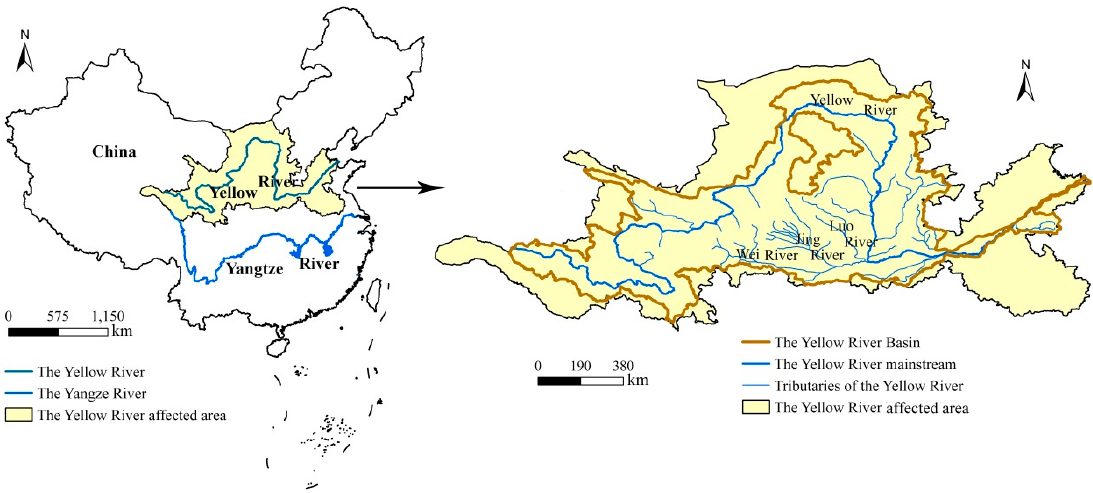
Figure 1. The location of the Yellow River affected area in China and an overview of the study area.